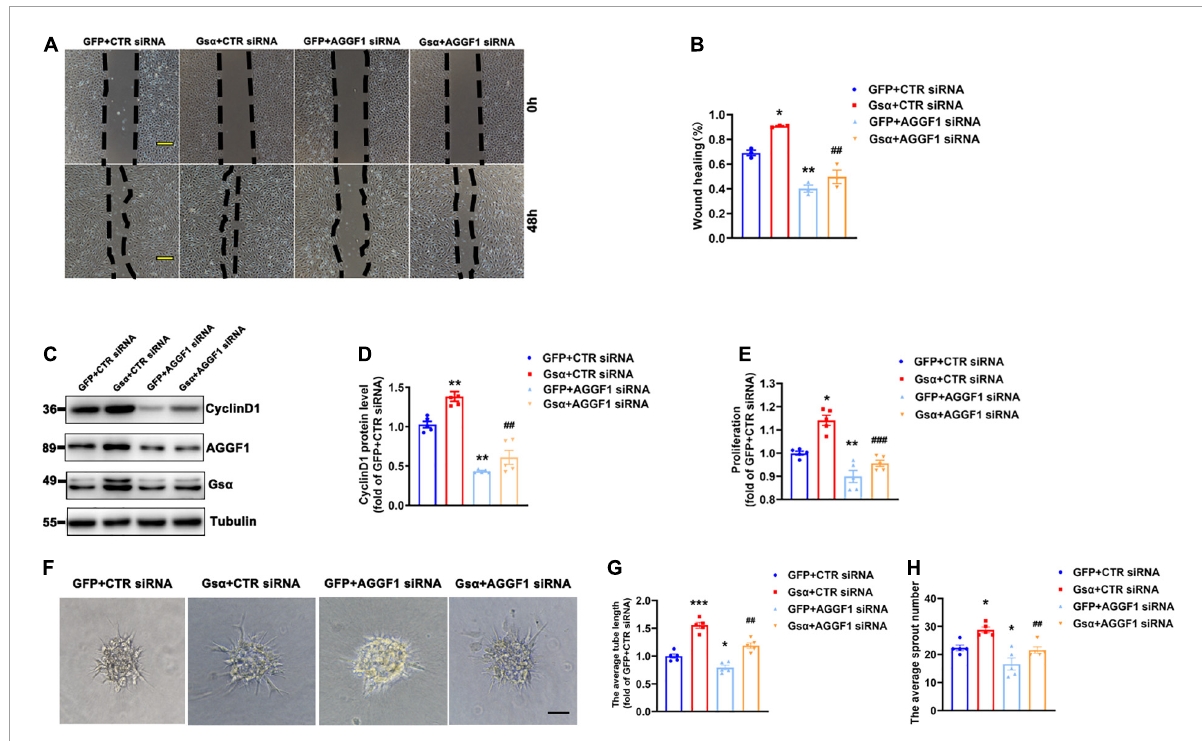
FIGURE6 Knockdown of AGGF1 attenuates the proangiogenic effect of Gs α in endothelial cells. (A) Representative scratch wound assays of HUVECs transfected with CTR or AGGF1 siRNA and infected with GFP or Gs α virus. Scale bar, 100 µ m. (B) Quantification of scratch wound closure of HUVECs shown in (A) . n = 3/group. (C,D) Western blot analysis and quantification of CyclinD1 protein level in HUVECs. n = 5/group. (E) Cell proliferation was measured in HUVECs by using a CCK8 ELISA kit. n = 5/group. (F) The spheroid assay of HUVECs transfected with CTR or AGGF1 siRNA and infected with GFP or Gs α virus. Scale bar, 100 µ m. (G,H) Quantification of the average sprout number and tube length of HUVECs transfected with CTR or AGGF1 siRNA and infected with GFP or Gs α virus. n = 5/group. * P < 0.05, ** P < 0.01, *** P < 0.001 vs. GFP + CTR siRNA, ## P < 0.01, ### P < 0.001 vs. Gs α + CTR siRNA (One-Way ANOVA and Bonferroni post-tests). Data are mean ±